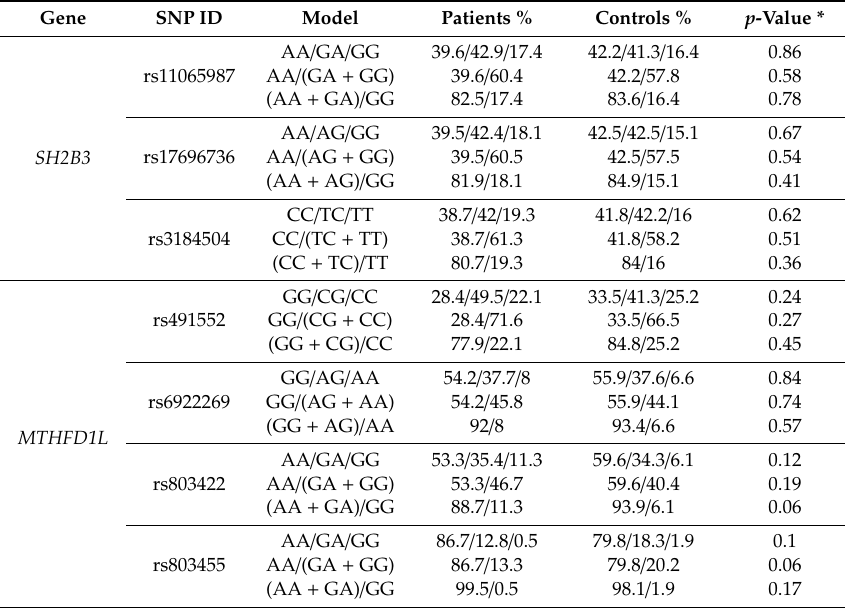
Table 1. The distributions of SH2B3 and MTHFD1L SNPs in 212 cardiovascular patients and 213 healthy